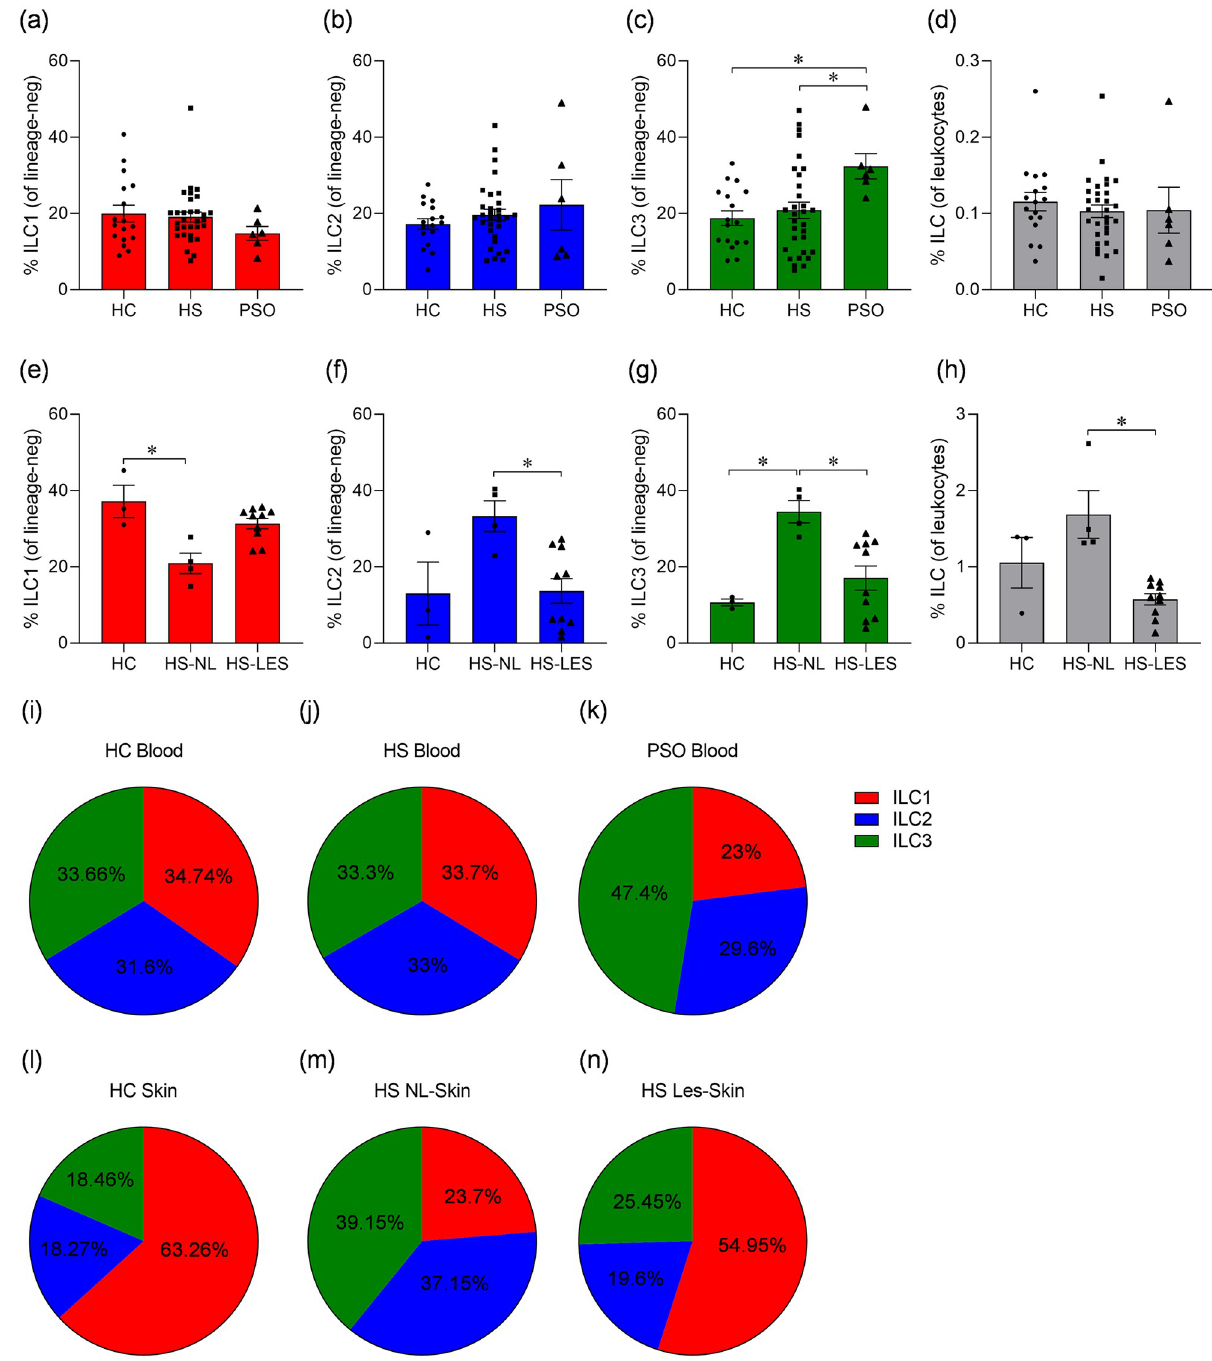
Fig 2. ILC frequencies in the blood and skin of hidradenitis suppurativa (HS) and psoriasis (PSO) patients compared to healthy controls (HC). PBMC and skin-derived cells were analysed by flow cytometry for frequencies of ILC types 1 (ILC1), 2 (ILC2) and 3 (ILC3) and total ILC. ILC were defined as CD45 + CD127 + lineage-negative, with ILC1 defined as CD117 - CD161 + , ILC2 defined as CD294 + and ILC3 defined as CD117 + NKP44 +/- . Lineage ‘cocktail’ included antibodies specific for CD1a, CD3, CD11c, CD14, CD19, CD34, CD94, CD123, CD303, FC ε RI, TCR αβ and TCR γδ . (a-c, e- g) average ( ± SEM) frequency of ILC1, ILC2, ILC3 (% of lineage-negative cells) in blood of healthy controls (HC, n = 17) and HS (n = 31) or psoriasis (PSO, n = 6)) patients (a-c), and skin of healthy individuals (HC, n = 3) and non-lesional (NL, n = 4) or lesional (LES, n = 10) skin of HS patients (e-g). (d,h) average ( ± SEM) frequency of total ILC of CD45 + cells (leukocytes) in blood (d) and skin (h). (i-n) pie charts depicting frequencies of ILC1, ILC2 and ILC3 as a proportion of total ILC in blood (i-k) and skin (l-n). � P < 0.05 using Kruskal-Wallis test with Dunn’s multiple comparisons.